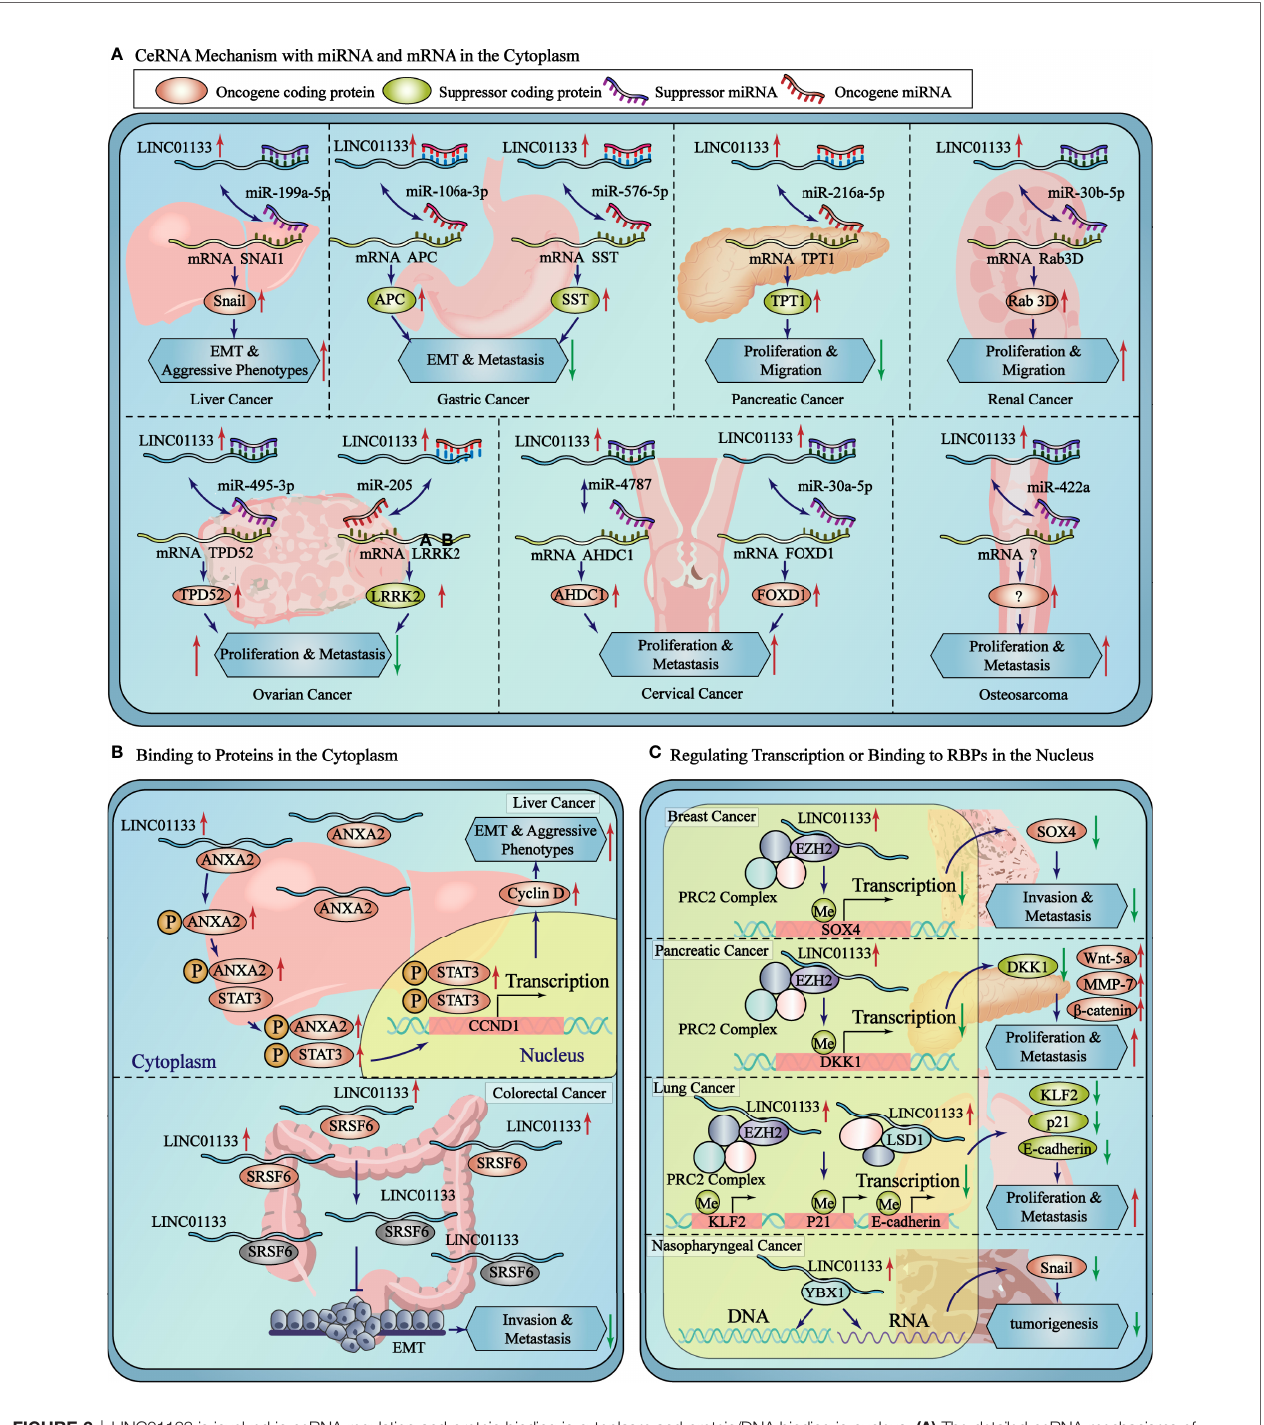
FIGURE 2 | LINC01133 is involved in ceRNA regulation and protein binding in cytoplasm and protein/DNA binding in nucleus. (A) The detailed ceRNA mechanisms of LINC01133 in the cancers of different tissue type. (B) LINC01133 bounds to proteins in cytoplasm to regulate the modi fi cation or activity of the target proteins. (C) LINC01133 bounds to proteins or DNA in nucleus to regulate the transcription of target genes. The blue rectangle represents the cytoplasm, and the yellow block represents the nucleus. The black dashed lines separate the cancers of different tissue